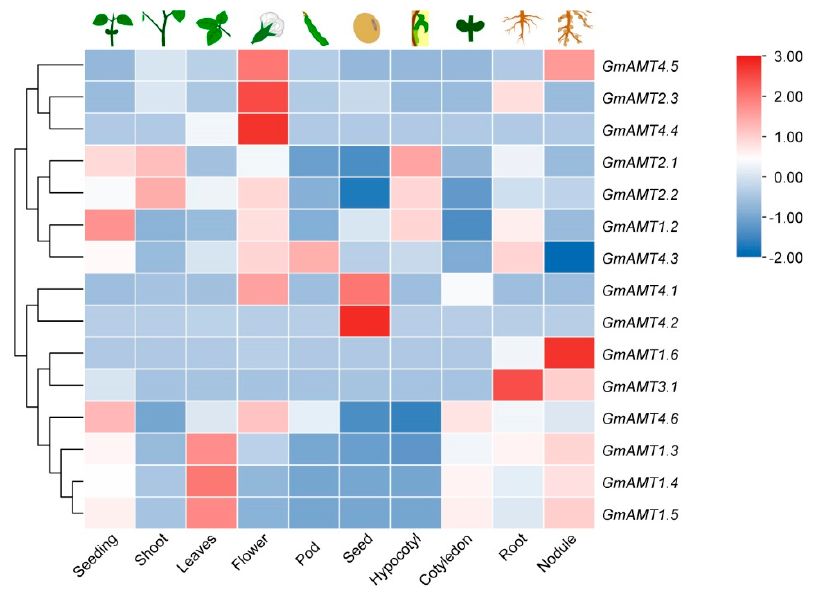
Figure 6. Heatmap of GmAMT expression in different tissues using RNA-seq data. The RNA-seq data were downloaded from the Soybean Expression Atlas website [44]. The color scale represents the normalized TPM value.